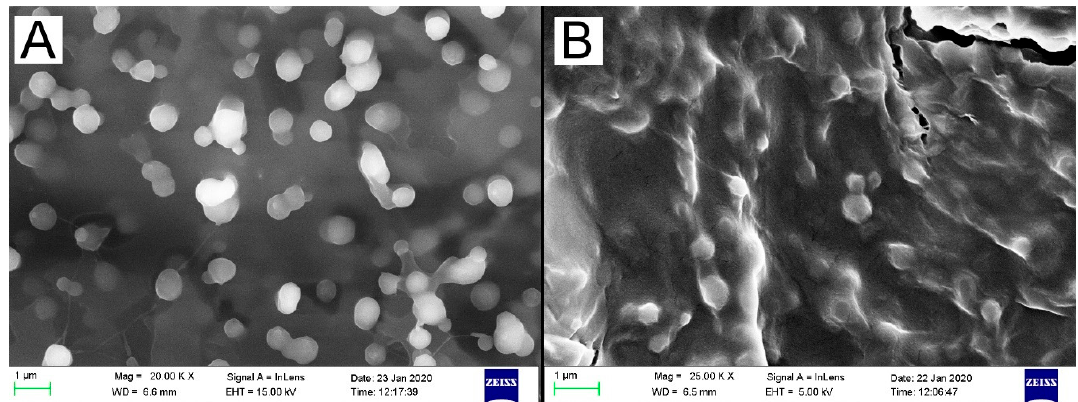
Figure 6. Scanning electron micrographs of nanoparticles prepared by emulsification solvent evaporation ( A ) and microfluidic ( B ) methods.